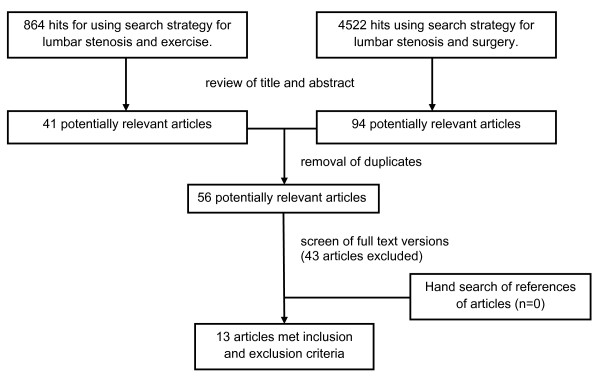
CONSORT flowchart.